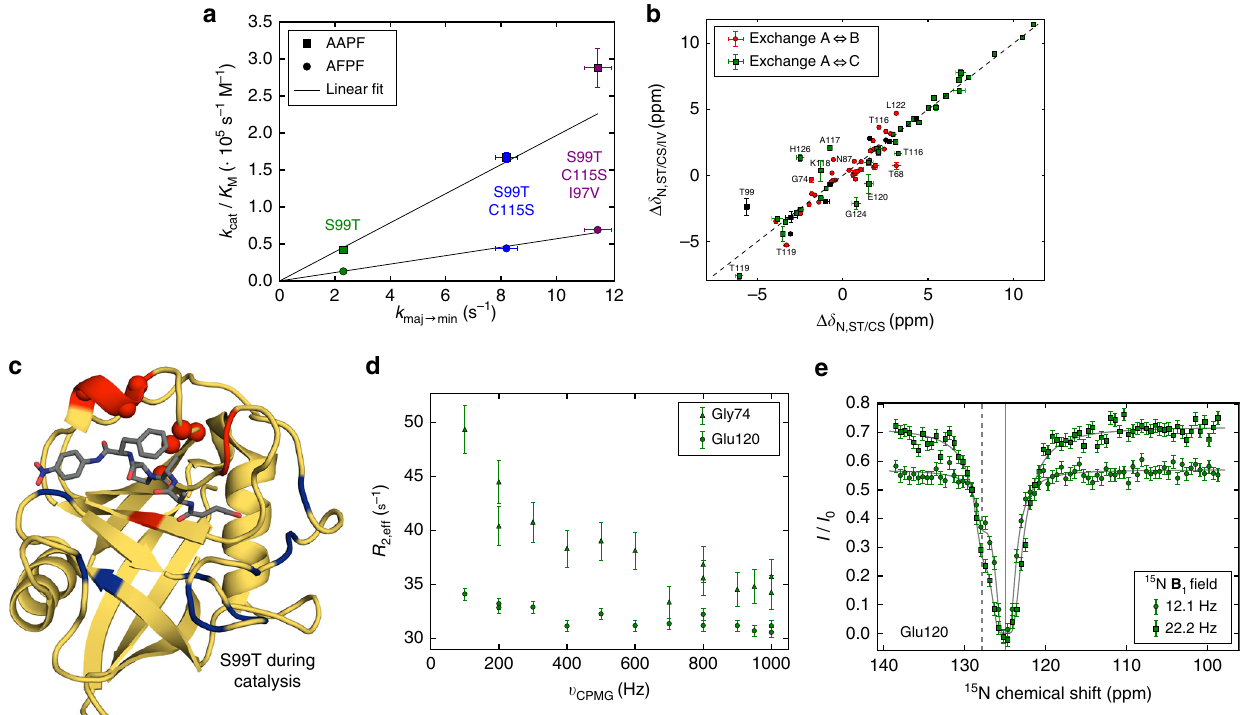
Fig. 3 Protein dynamics during turnover and catalytic ef fi ciency correlate. a Correlation between k cat / K M and k maj → min measured by CEST across all rescue mutations for apo protein fi tted using orthogonal distance regression through the origin (AFPF: adj. R 2 = 0.999, χ 2 red = 1.1; AAPF: adj. R 2 = 0.995, χ 2 red = 3.7). b Correlation of the chemical shift differences between major and minor conformations for the two processes observed in S99T/C115S and S99T/ C115S/I97V. Residues within 5 Å of mutation site (I97V) are shown in black and assignments are given if the variation in Δ δ is >1.5 ppm. c Quantitative analysis of fast and slow protein dynamics of CypA S99T during catalysis of Suc-AFPF-pNA peptide (gray sticks) measured by NMR. CPMG relaxation dispersion experiments revealed, similarly as in apo S99T, fast motion mainly in the fl exible loop (blue) and a slow process (red) consistent with the CEST data (spheres). d Representative CPMG pro fi les for a residue in fast (Gly74) and slow (Glu120) exchange and e CEST pro fi le for Glu120 during catalysis (see Supplementary Data 7 and 8 for all pro fi les). Error bars in a and b denote the (propagated) standard errors in the fi tted parameters. The uncertainties in CPMG ( d ) and CEST ( e ) data are determined as described in Fig.